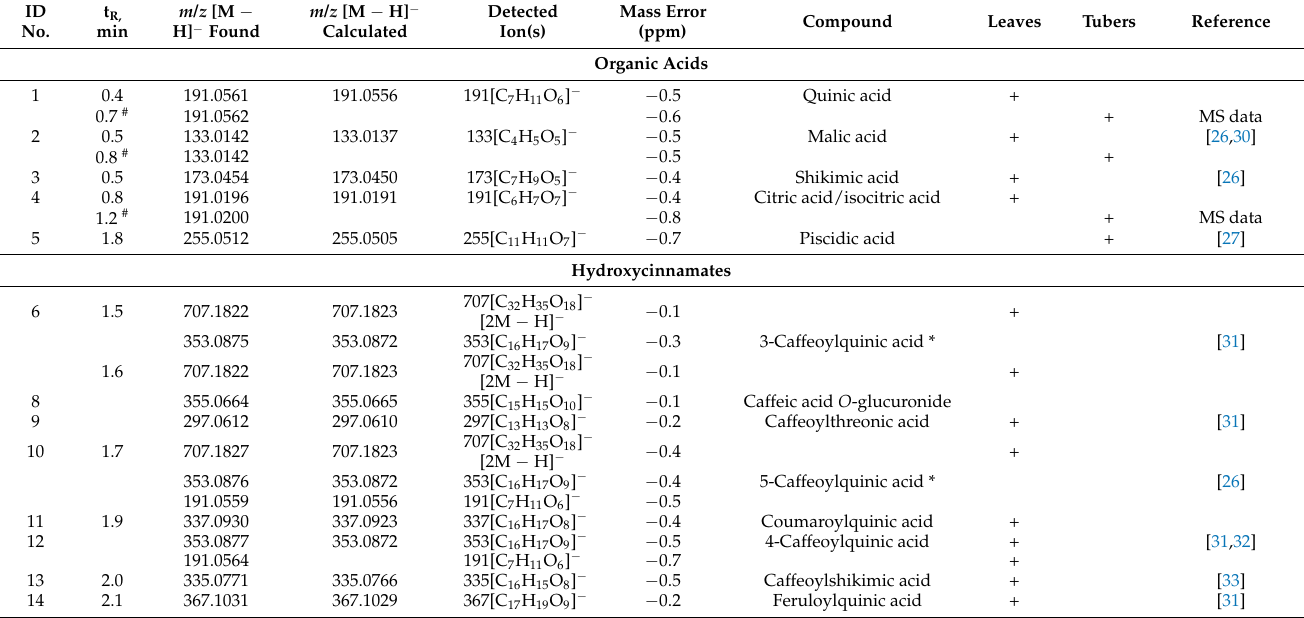
Table 1. Identification data of the constituents detected in D. caucasica leaf and tuber extracts by UPLC/Q-TOF-MS in negative ion